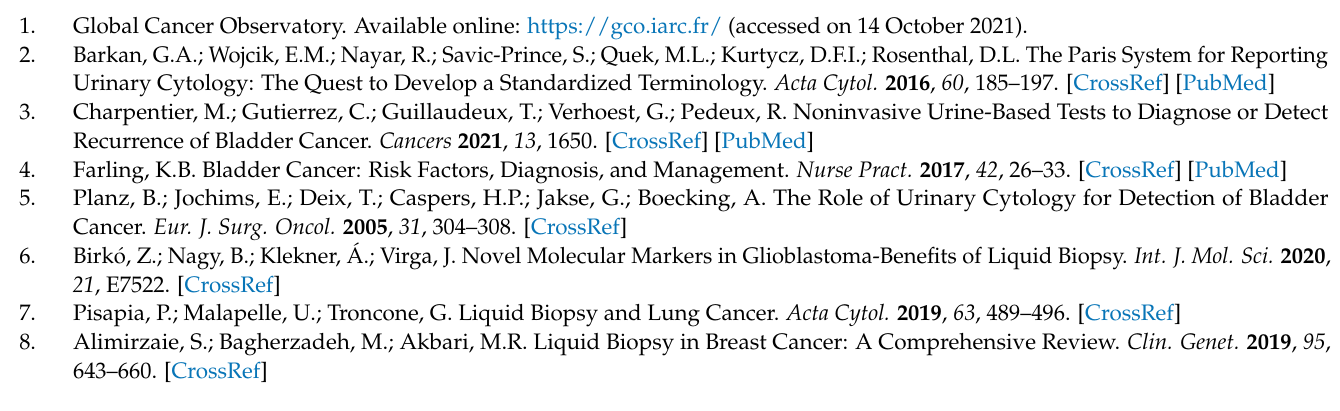
Figure S5: Involvement of senescence in the modulation of PMF, Figure S6: Involvement of the treat- ment on the modulation of PMF, Figure S7: Total cell death determination by flow cytometer after induction of cellular stress by irradiation and treatment on T24, Figure S8: Disruption of the plasma membrane by miltefosine treatment, Figure S9: Original blots of Figure 5D.; Method S1: Plasma membrane composition modulation assay. Video S1: Example of a FPM quantification by the Perifluo QCG